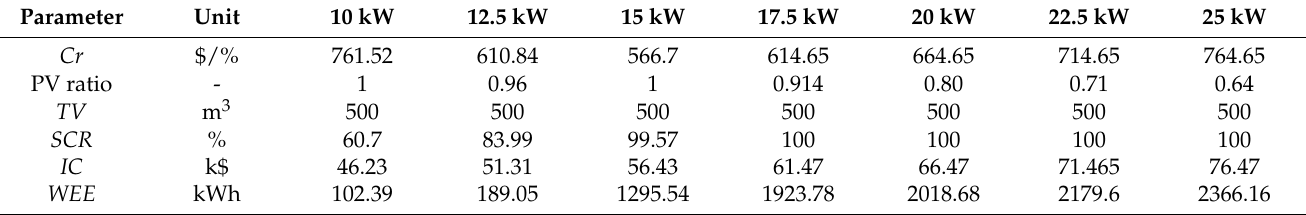
Table 4. Optimal configurations for each HRES rated power for wine grapes in Suhindol with mSi PV panels and WT type 5. Parameter